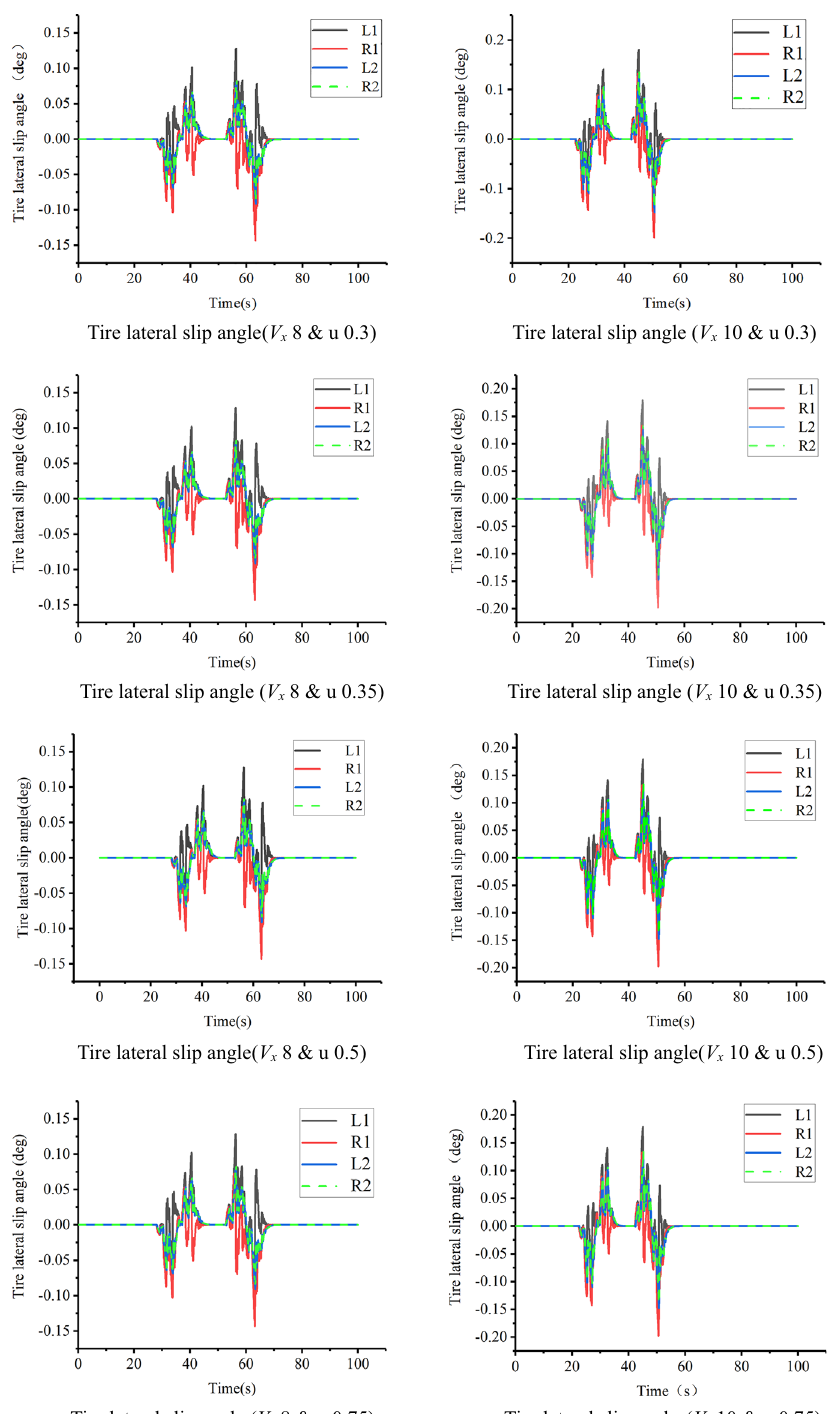
Figure 29. Comparison of tire lateral slip